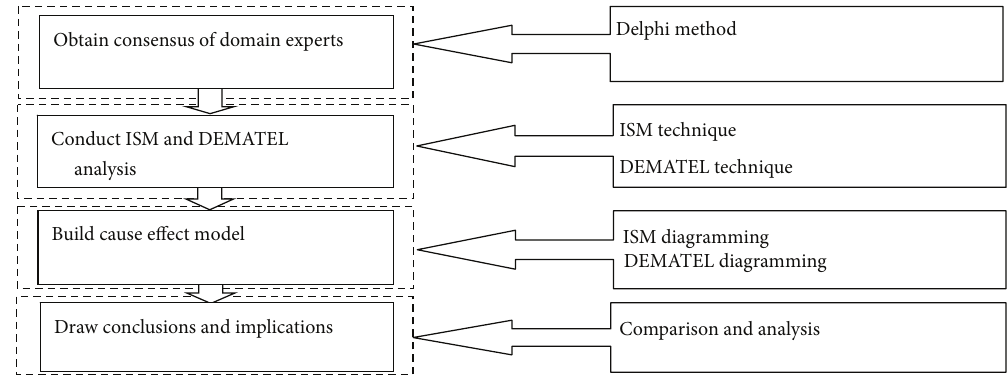
Figure 3: Flowchart of the proposed method of the study.